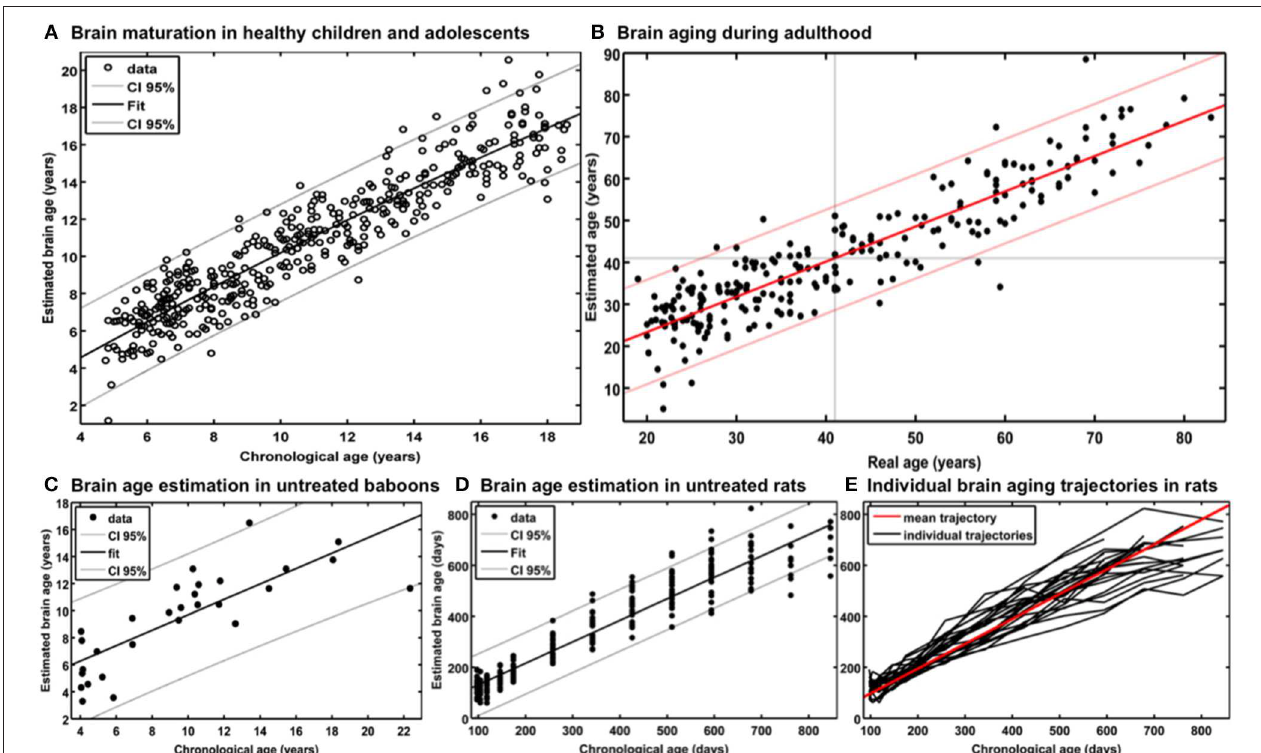
FIGURE 2 | Reference curves for BrainAGE . (A) Individual structural brain age based on anatomical T1-images of 394 healthy subjects (aged 5–18 years). Chronological age is shown on the x-axis and the estimated brain age on the y-axis. The overall correlation between estimated brain age and chronological age is r = 0.93 ( p < 0.001), and the overall MAE = 1.1 years. The 95% confidence interval of the quadratic fit is stable across the age range ( ± 2.6 years). [Figure and legend reproduced from Franke et al. (45), with permission from Elsevier, Amsterdam.] (B) Estimated brain age and chronological age are shown for the whole test sample with the confidence interval (red lines) at a real age of 41 years of ± 11.5 years. The overall correlation between estimated brain age and chronological age is r = 0.92 ( p < 0.001), and the overall MAE = 5.0 years. [Figure and legend modified from Franke et al. (32), with permission from Elsevier, Amsterdam.] (C) Scatterplot of estimated brain age against chronological age (in years) resulting from leave-one-out cross-validation in 29 healthy control baboons using their in vivo anatomical MRI scans. The overall correlation between chronological age and estimated brain age is r = 0.80 ( p < 0.001), with an overall MAE of 2.1 years. [Figure and